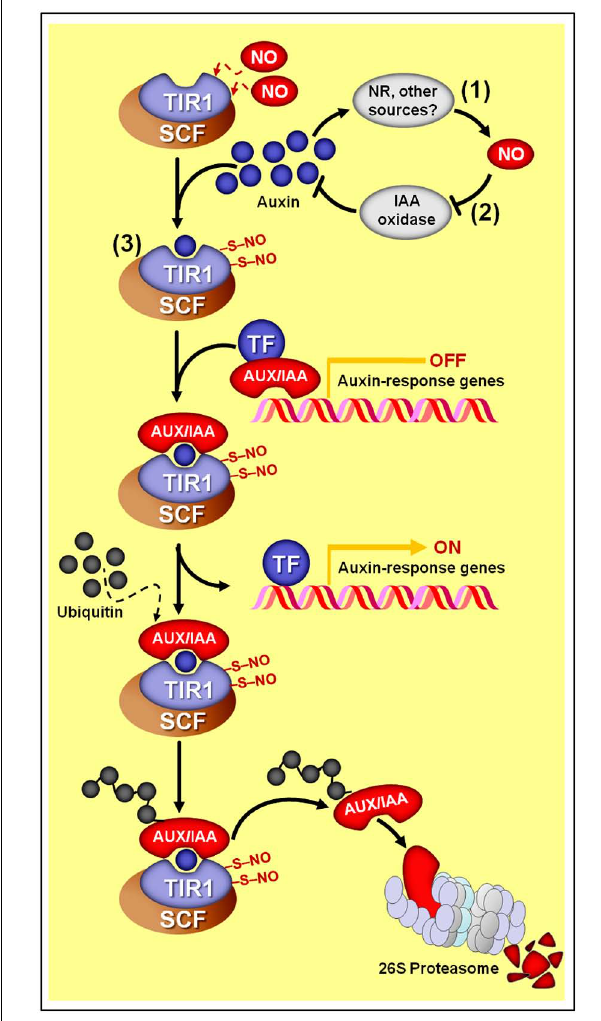
FIGURE 4 | Schematic representation of NO–auxin synergist interac- tions. (1) Auxins stimulate NO production in several plant materials and experimental conditions. In most cases, nitrate reductase (NR) seems to be the main biosynthetic source of auxin-induced NO production. (2) In M. truncatula roots, NO promotes auxin accumulation by repressing its degradation via IAA-oxidase. (3) In Arabidopsis , NO might also positively impact auxin signaling since the auxin receptorTRANSPORT INHIBITOR RESPONSE 1 (TIR1) may undergo S -nitrosylation at cys-140 and cys-480, which promotes its interaction with AUXIN/INDOLE-3-ACETIC ACID (AUX/IAA) proteins. Subsequently,TIR1 marks AUX/IAA proteins to degradation through SCF-26S proteasome-mediated proteolysis, thereby de-repressing the transcription of auxin-regulated genes. Protein S -nitrosylation is represented by